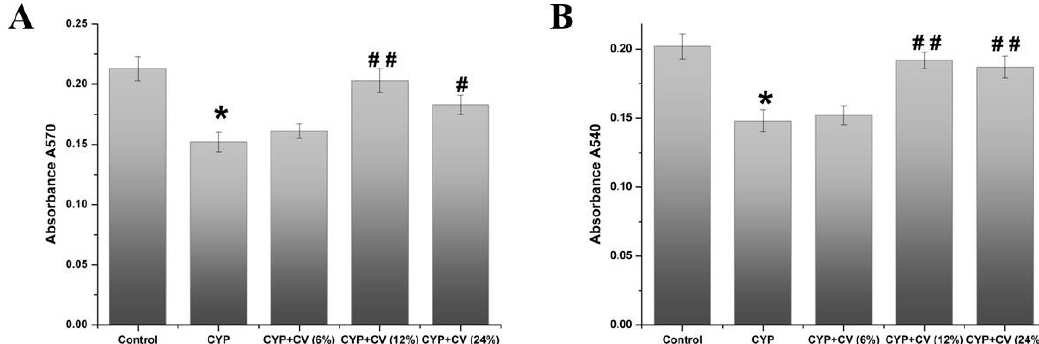
Figure 4. Effects of CV on proliferation ( A ) and phagocytosis activity ( B ) of peritoneal macrophages in CYP-treated mice. Note: Data were expressed as mean ± SD, *: only the CYP treatment was compared against the control treatment ( p < 0.05); #: only the CYP + CV treatment was compared against the CYP treatment ( p < 0.05), ##: only the CYP + CV treatment was compared against the CYP treatment ( p < 0.01).